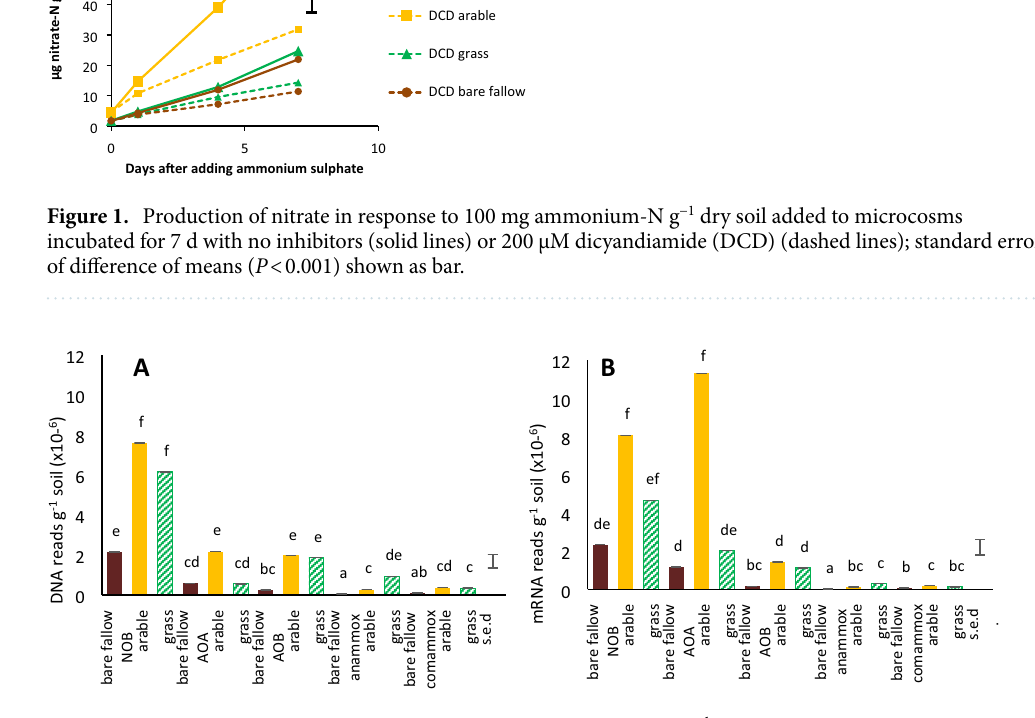
tively, all significantly different from each other but not from the same plots for the previous three years with no interaction between treatment and years, which justified using the three-year mean estimate of prokaryotic cells. The RNA extracted at the same time (average read length 87 nt) gave 1 × 10 8 , 2 × 10 8 and 3 × 10 8 sequences cor-